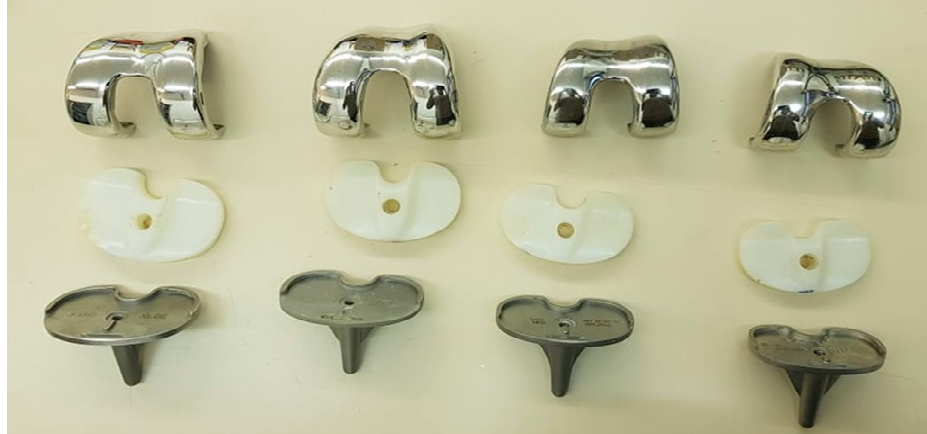
Figure 7. Femur, Tibia, and the guide.